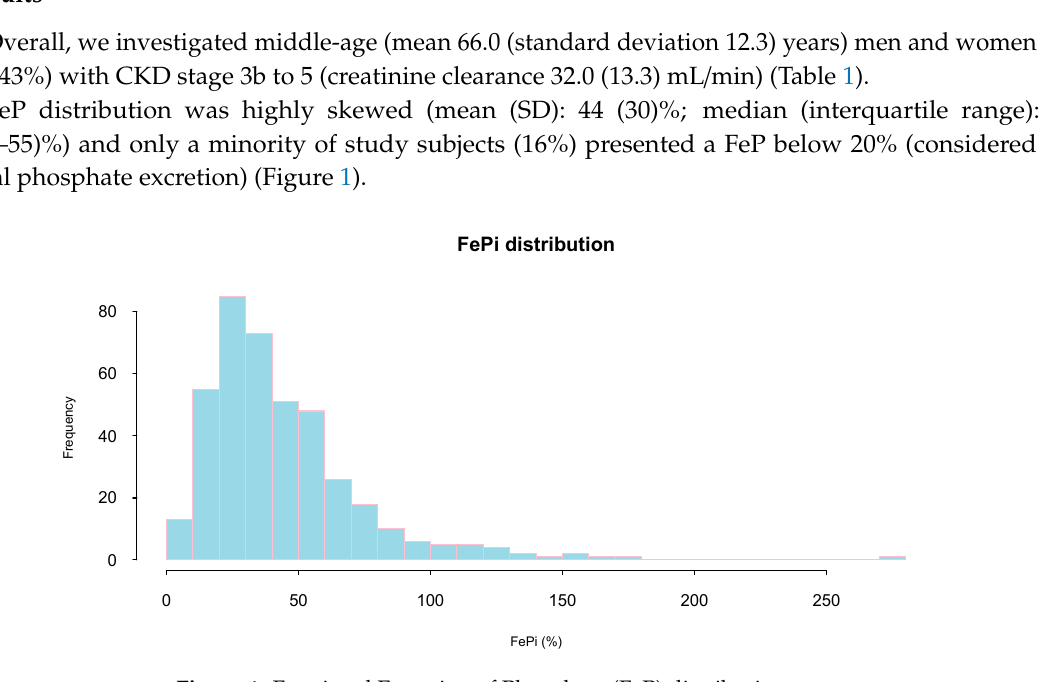
Table 2. predictors of Fractional Excretion of Phosphate (FeP) at linear regression analysis.